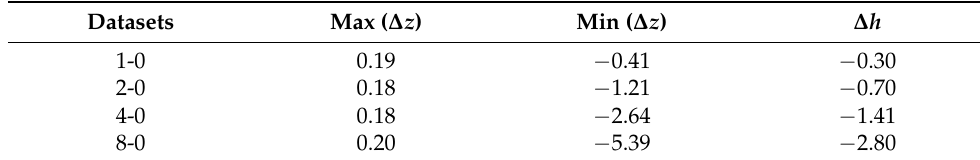
Figure 9. Histograms of height differences (m): ( a ) 1 cm; ( b ) 2 cm; ( c ) 4 cm; ( d ) 8 cm. Table 2. The threshold values for different subsidence datasets (cm).